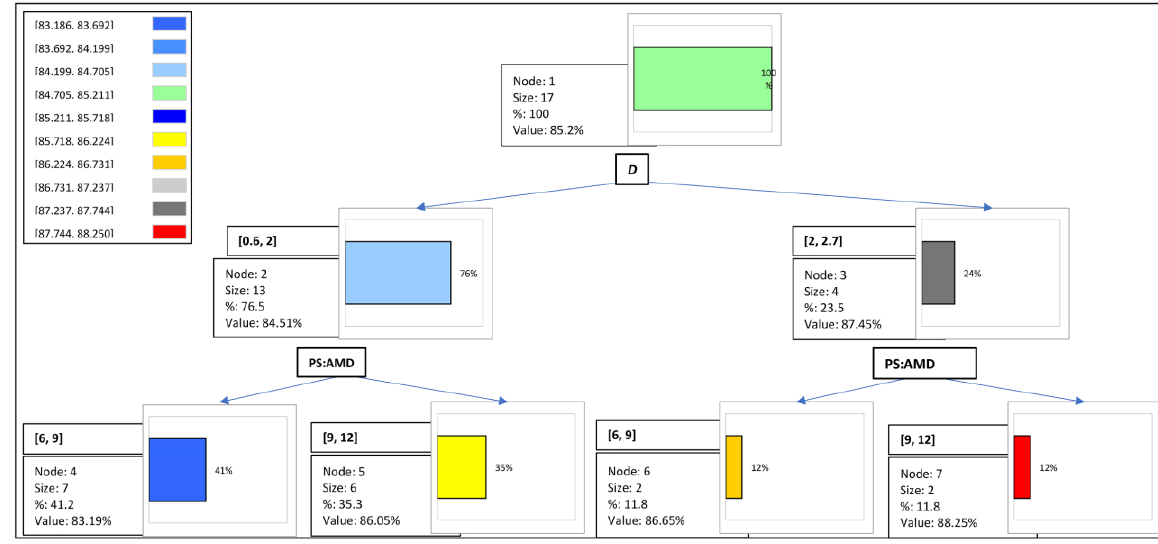
Figure 5. Regression tree: decision making for TSS .